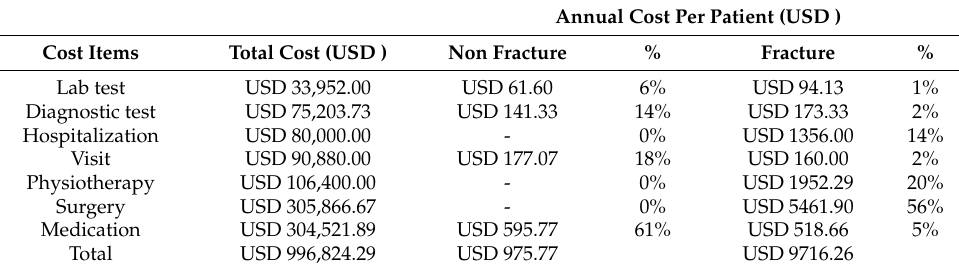
Table 3. Cost estimation for patients with osteoporosis.